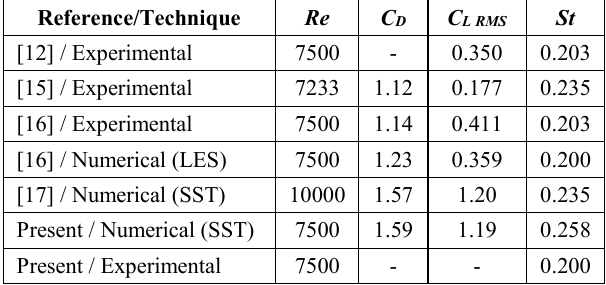
Table 1. Comparison of the current results with those of other authors for bare cylinder.